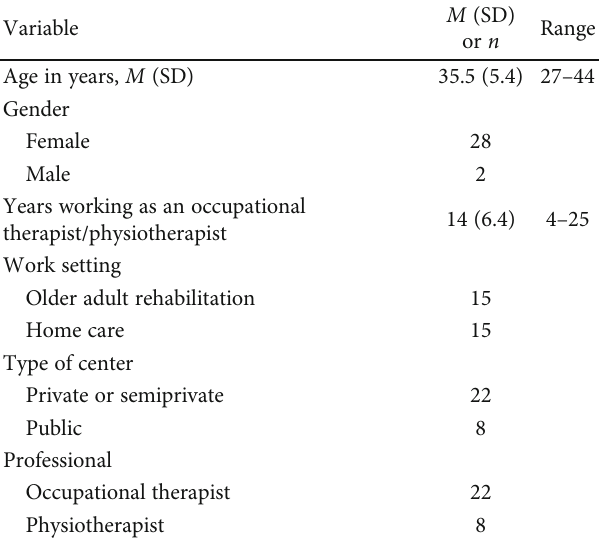
Table 1: Participant characteristics ( N = 30